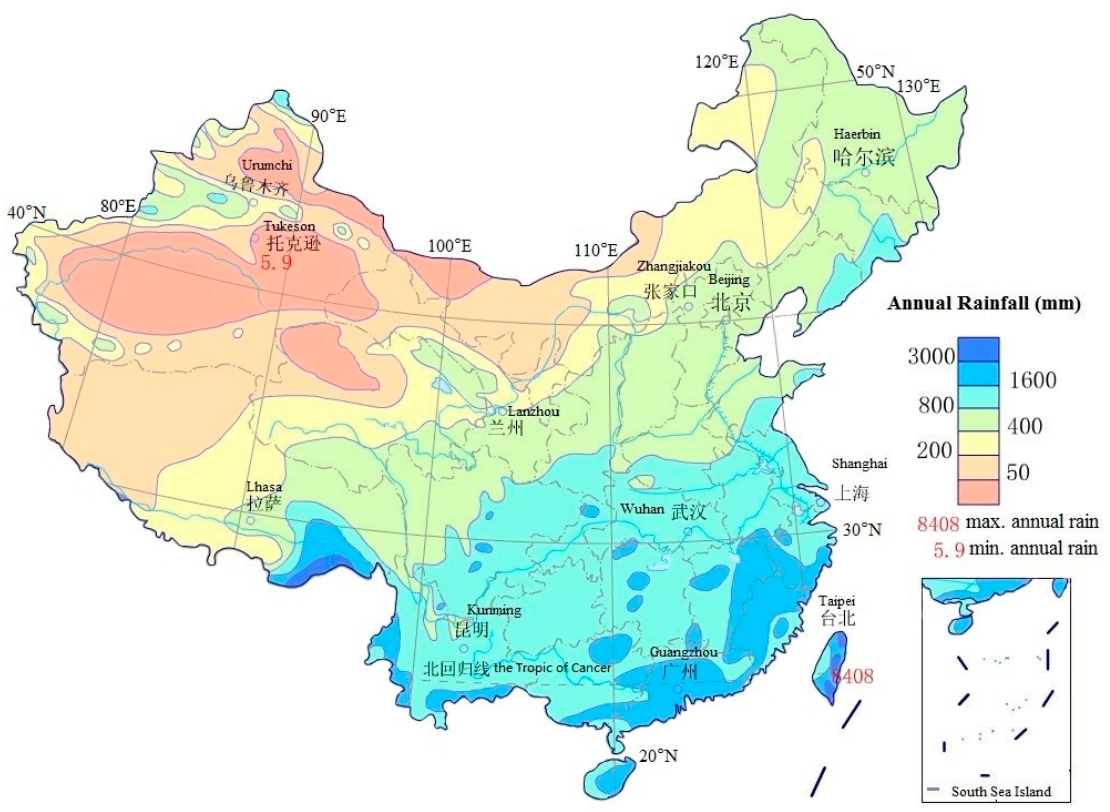
Figure 3. Annual precipitation distribution in China.